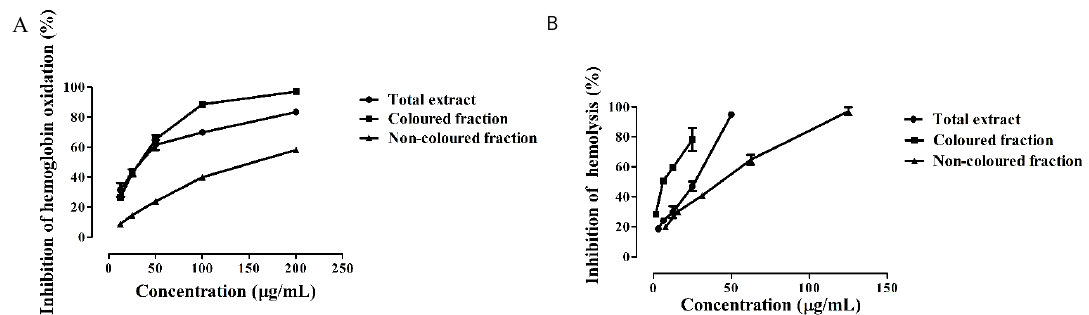
Figure 2. Inhibition of ( A ) hemoglobin oxidation and ( B ) hemolysis by Saco sweet cherry